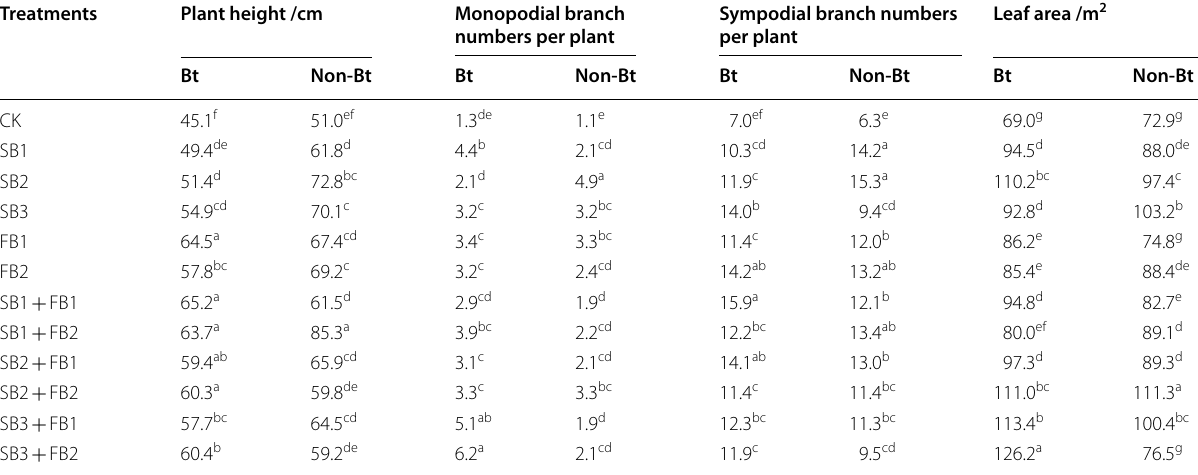
Values are means of three replicates with two plants per replicate (n SB1: 1 mg spray; SB1